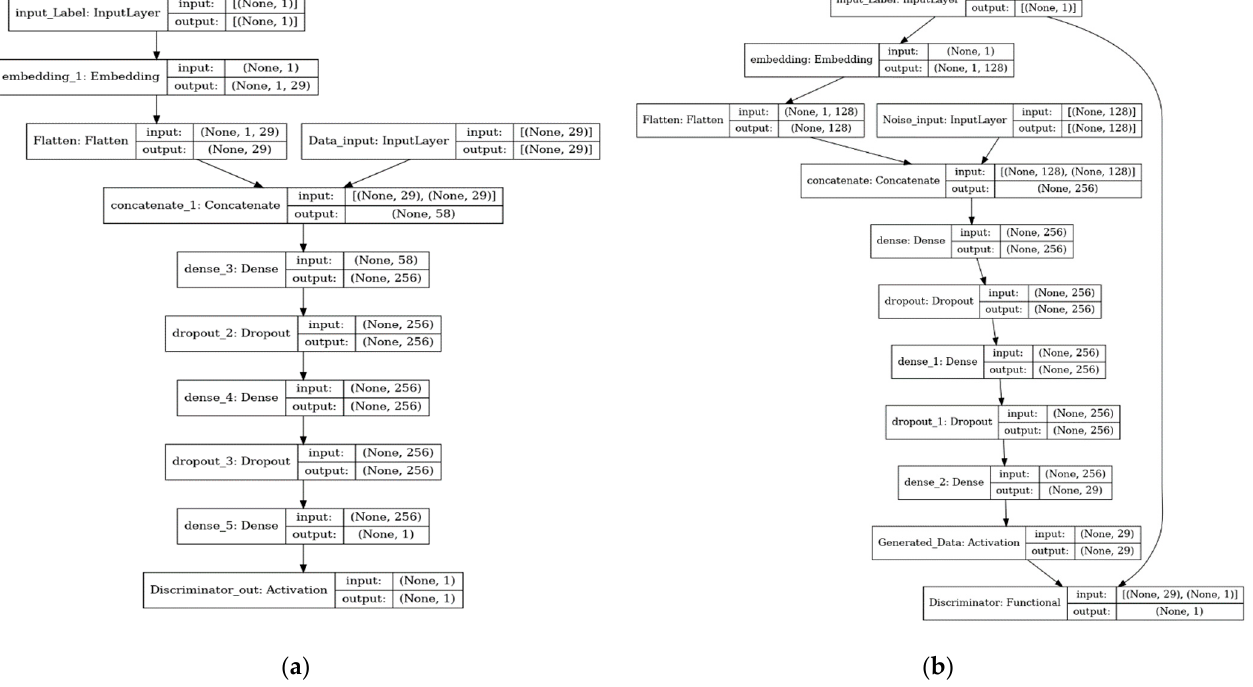
Figure 1. The architecture of K-CGAN: ( a ) K-CGAN Discriminator Architecture; ( b ) K-CGAN Gen- erator Architecture with Novelty Loss.